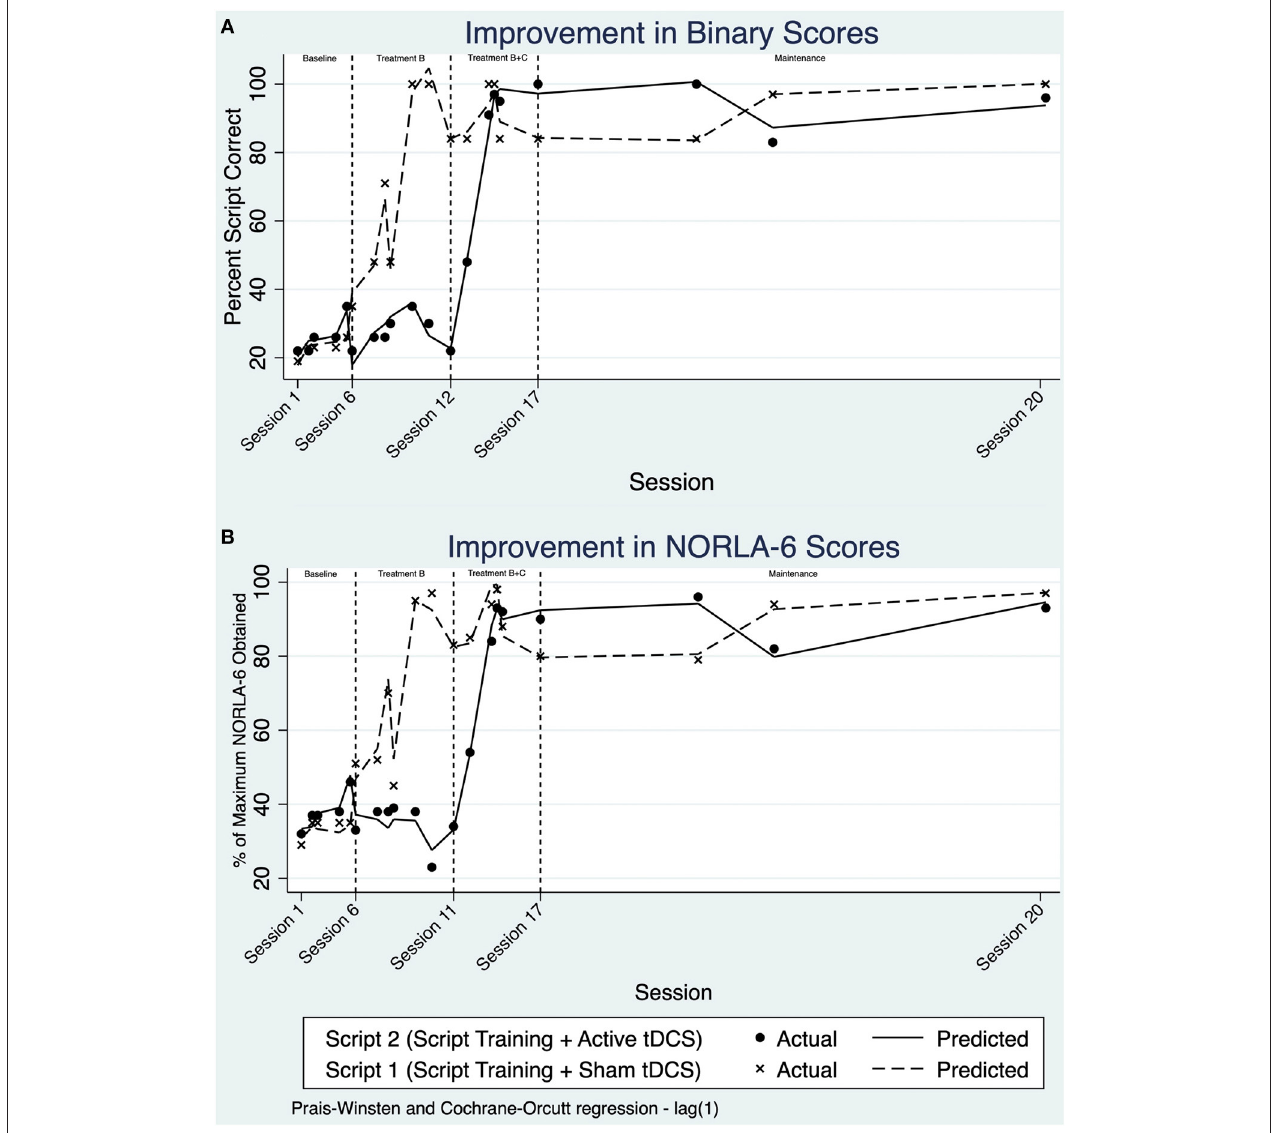
FIGURE 2 | (A) Line chart of percent script correct using binary scoring over treatment sessions and maintenance. (B) Line chart of percent script correct using NORLA-6 scoring over treatment sessions and